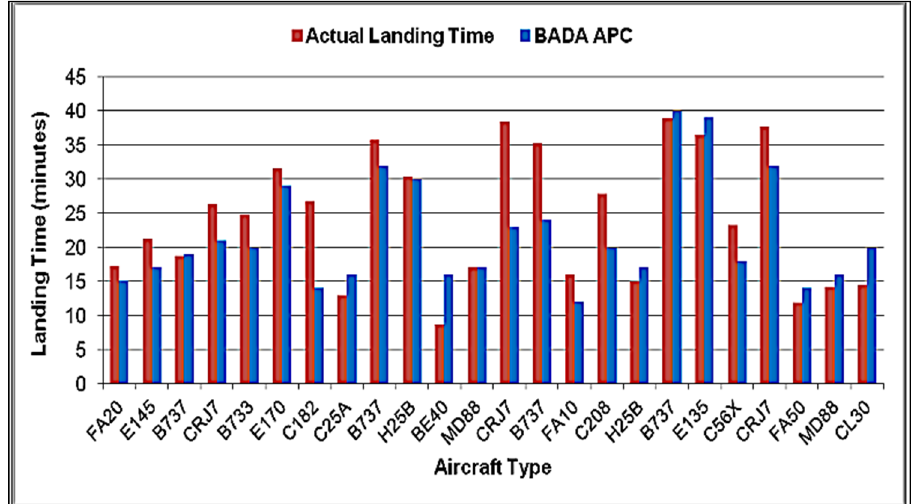
Figure 5. Evaluation of aircraft landing times with SDA at BNA.